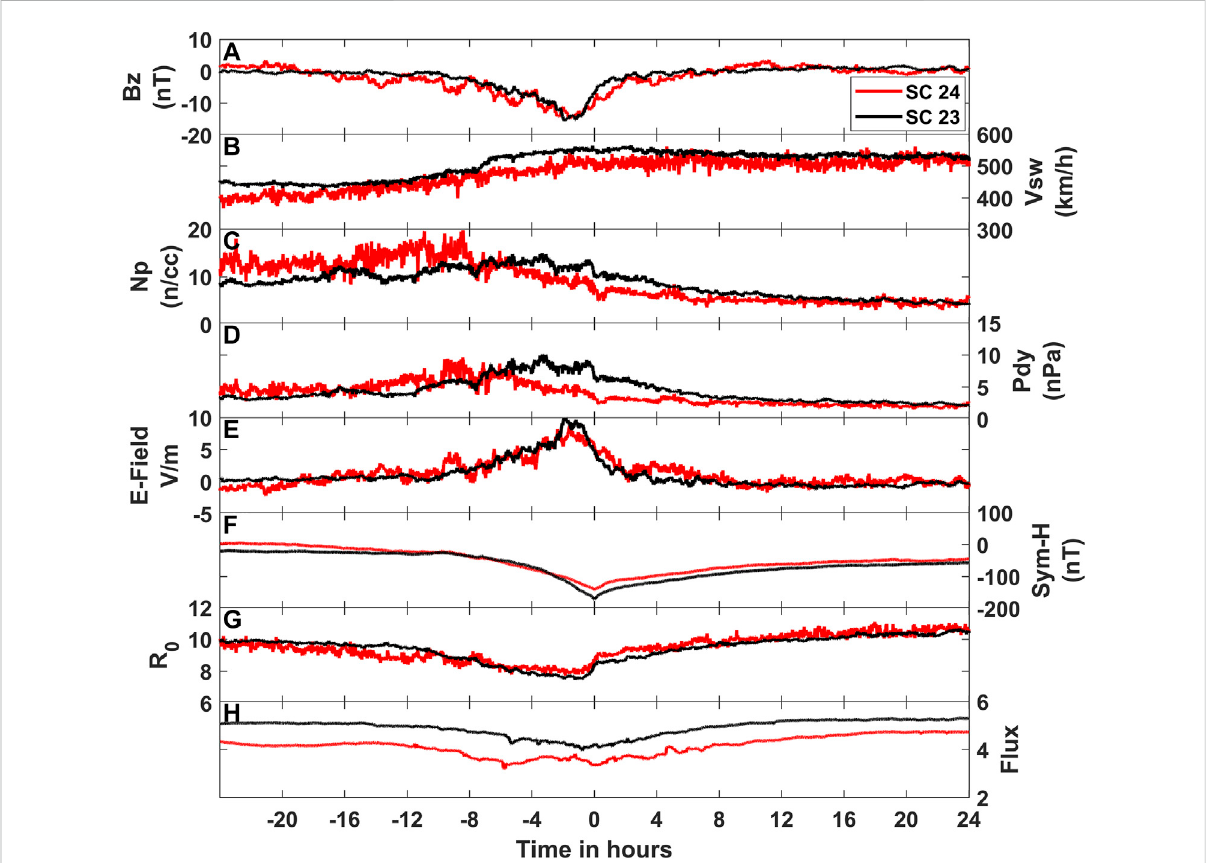
FIGURE 4 Superposed epochanalysis performed on thevarious interplanetaryconditions: (A) IMF Bz (nT), (B) solar wind speed, Vsw (km/h), (C) solar wind density, Np (n/cc), (D) solar wind dynamic pressure, Pdy (nPa), (E) electric fi eld (V/m), (F) Sym-H (nT), (G) magnetopause stand-off distance, R 0 (R E ), and (H) GOES > 0.6 MeV electron fl ux(ecm − 2 s − 1 sr − 1 )for thestorms thoseoccurredduring solar cycle23(black curve)and solarcycle24